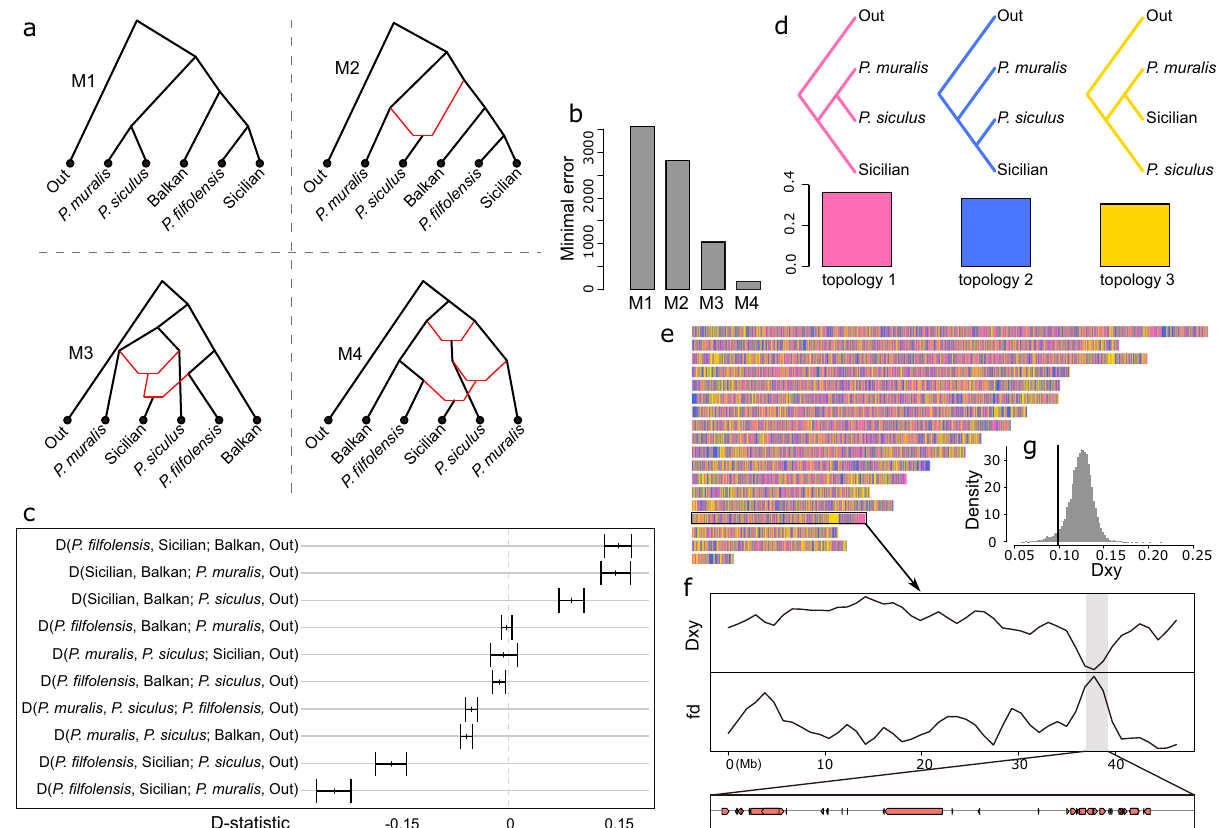
Fig. 4 Reticulate evolution of wall lizards in the Sicilian-Maltese group. a Proposed scenarios for the evolutionary history of wall lizards in Sicily and its surrounding area based on phyloNet networks: M1 — consensus tree with no introgression; M2 — an ancient introgression from the MRCA of Balkan and the two island groups into the P. siculus clade; M3 — introgressions from P. muralis and P. siculus clades into the MRCA of the Sicilian subclade ( P. raffonei and P. waglerianus ); M4 — all three reticulations combined. b The minimal errors for the four scenarios fi tted by linear algebra and numerical optimization. c The observed D-statistic values for the species in the testing topologies. The dots represent the D-statistic scores, and the error bars represent their standard deviations. d Proportion of tree topologies supporting alternative relationships among P. muralis , P. siculus and the Sicilian subclade. e Distribution of tree topologies across the genome. Each colour concords with the topology in panel d . f 50 Kb window-based Dxy and fd statistics between P. muralis and the Sicilian subclade across Chromosome 15. The area shaded in grey marks a genomic block (36.3 – 39.5 Mb) of introgressed ancestry with low Dxy and high fd values containing 39 coding genes. g The genome-wide distribution of Dxy values between P. muralis and the Sicilian subclade based on 50 Kb window. The black line indicates the Dxy for the genomic block highlighted in panel f showing signi fi cant excess of allele sharing (Supplementary Fig. 14).